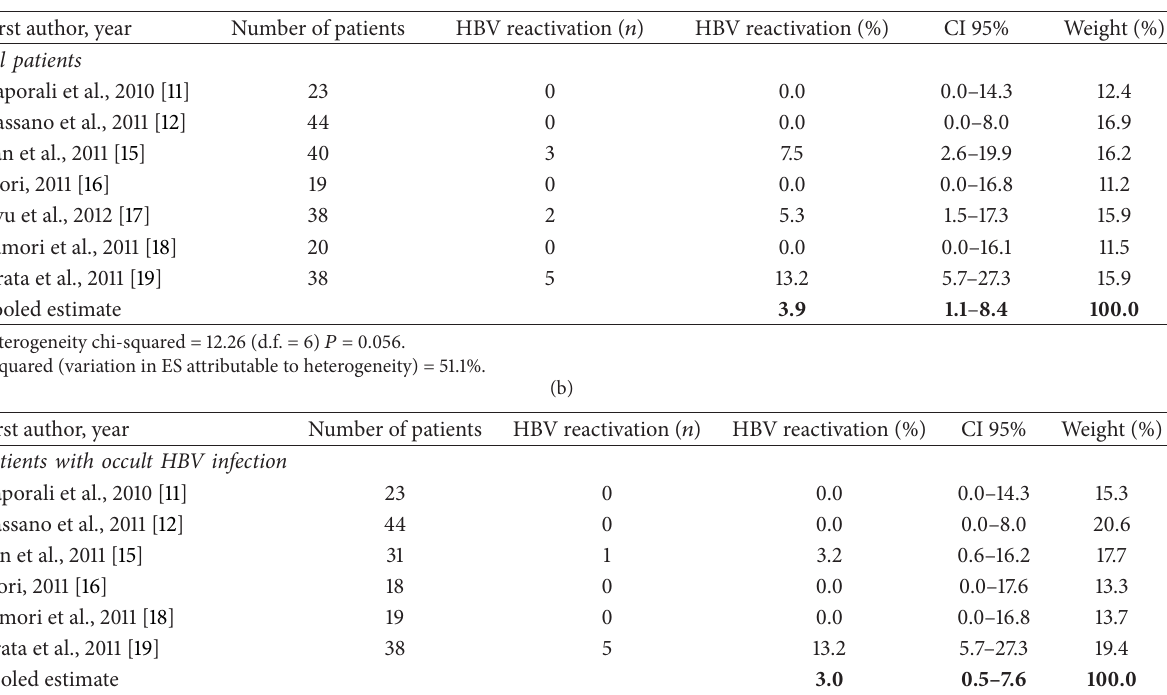
Table 4: Meta-analysis on HBV reactivation among patients treated with etanercept.